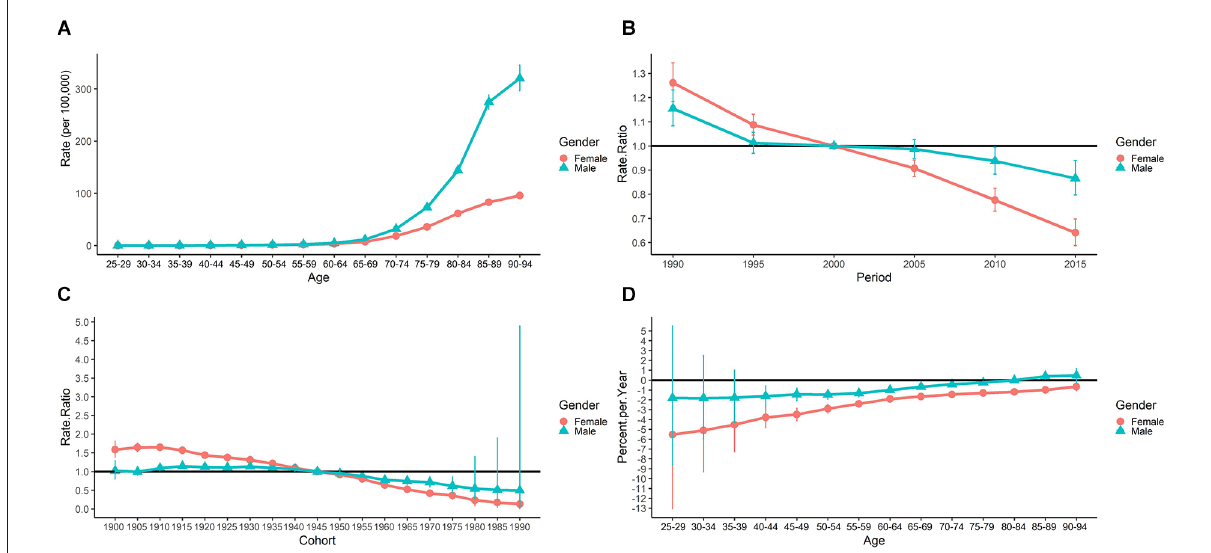
FIGURE3 Results of APC analysis for PD mortality from 1990 to 2019. (A) Longitudinal age curve of PD incidence (per 100,000) by gender. (B) Period RR by gender. (C) Cohort RR by gender. (D) Local drifts by gender.